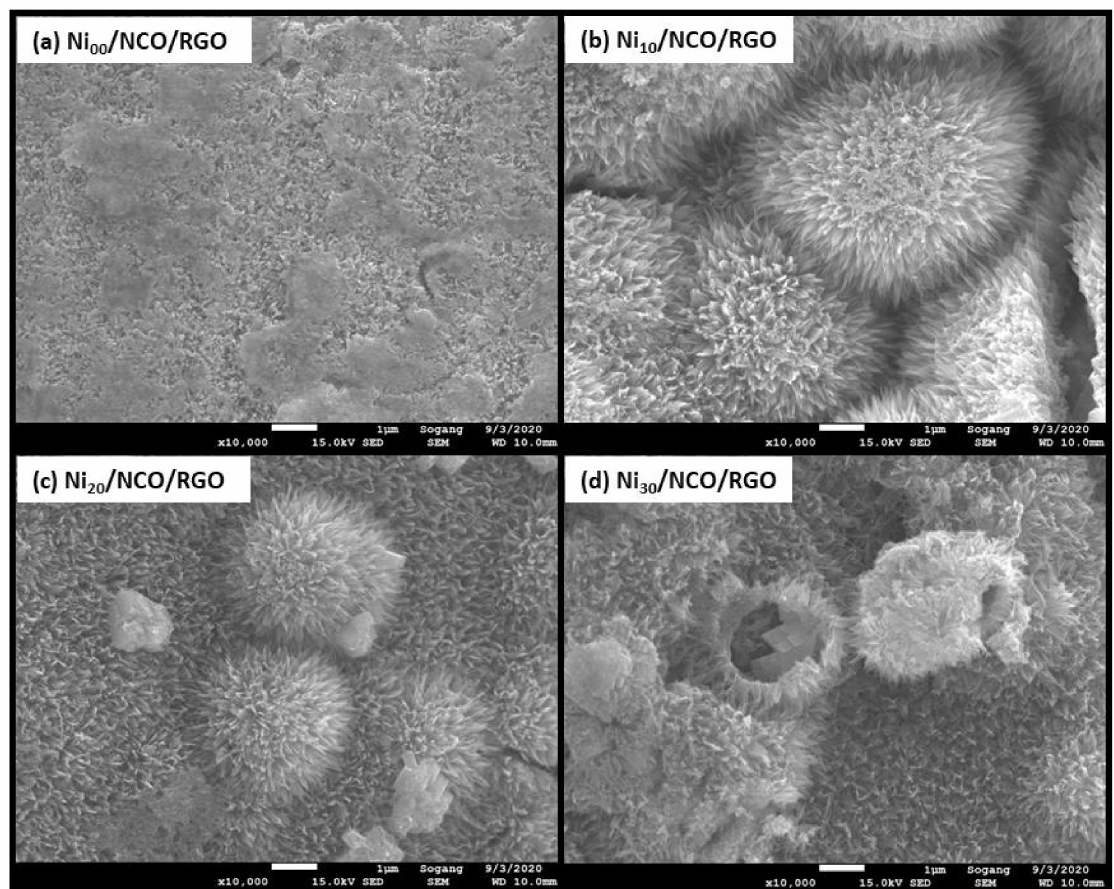
Figure 3. FE-SEM images of NCO/RGO hybrid nanostructures coated onto unetched and etched Ni